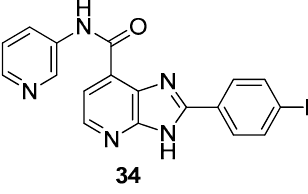
Figure 11. Imidazo[4,5- b ]pyridine derivative with antidiabetic activity.